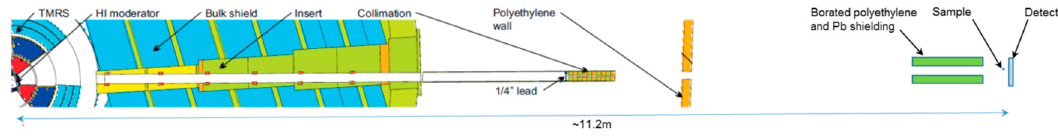
Figure 1. Flight Path 5 Schematic. Note that the polyethylene walls and the borated polyethylene and Pb shielding were not used for the measurements reported here.